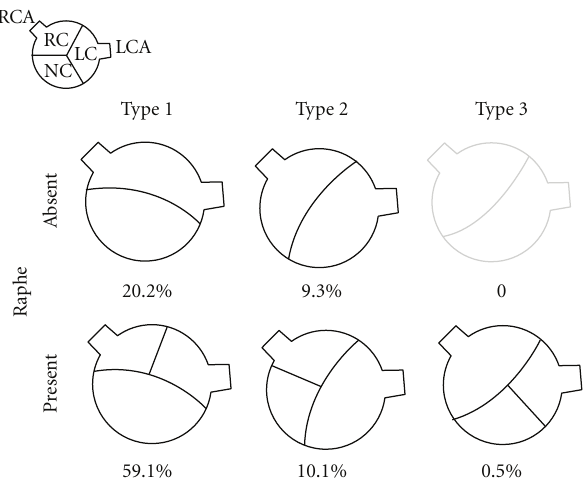
Figure 2: The classification and incidence of bicuspid aortic valves according to site of cusp fusion.